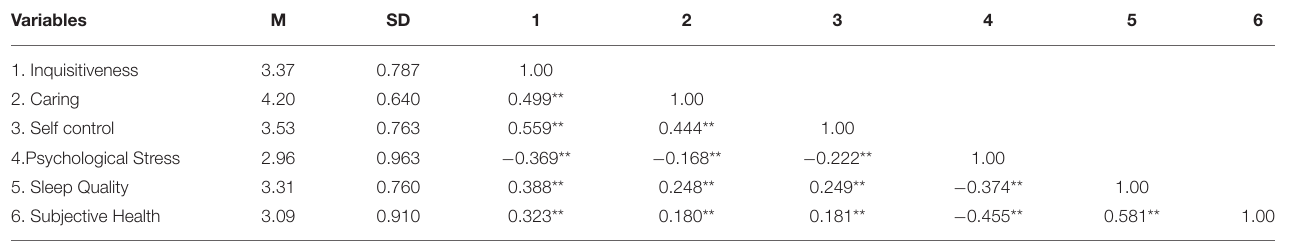
TABLE 4 | Multiple hierarchical linear regression models of variables [character strengths (CS), psychological stress, sleep quality, subjective health] ( n = 1,221). Variables